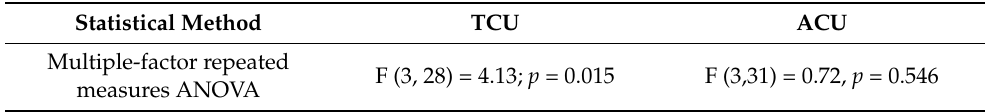
Table 9. Comparisons for the influence of the interaction between task demand and circadian rhythm on PERCLOS values by work type.